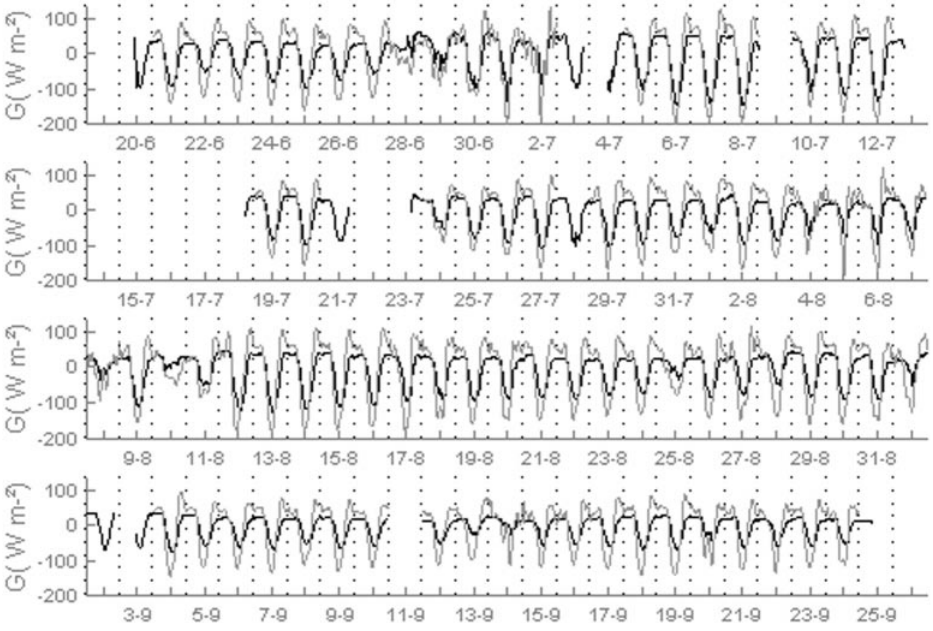
Fig. 11. Time series of the mea- sured soil heat flux ( black ) and the calculated one at the surface ( grey ) for 1997 WELSONS ex- periment. As for soil and soil surface temperature, data come from the station installed on the RT plot and missing data are due to the same reasons, except on 9 July and the 11 September because a test on the soil heat flux plate was removed from